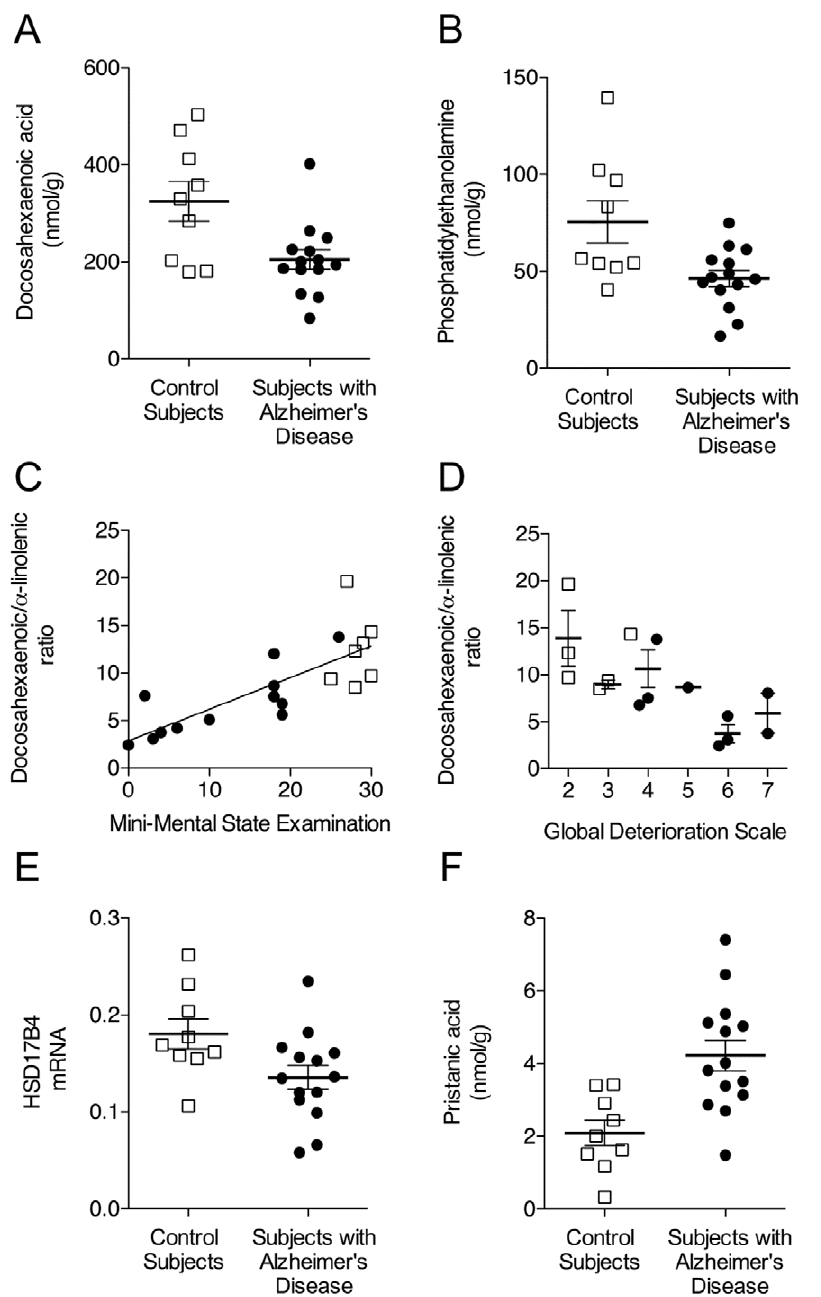
Figure 2. Liver metabolism in Alzheimer’s disease patients. Levels of free docosahexaenoic acid (Panel A) and 1-O-1 9 -( Z )-octadecenyl, 2- docosahexaenoyl- sn -glycero-3-phosphoethanolamine (Panel B) in liver tissue from control subjects (open squares) and Alzheimer’s disease patients (closed circles). Correlation between individual docosahexaenoic/ a -linolenic ratios in liver and most recent Mini-Mental State Examination scores (Panel C) or global deterioration scale grades (Panel D). HSD17B4 mRNA, encoding for D -bifunctional protein (Panel E) and pristanic acid levels (Panel F) in liver from control subjects (open squares) and subjects with Alzheimer’s disease (closed circles). Lipid content is expressed in nanomoles per gram of wet tissue and mRNA levels are expressed in arbitrary units. There were statistically detectable differences between control subjects and Alzheimer’s disease patients in the levels of docosahexaenoic acid (P=0.0077) and 1-O-1 9 -( Z )-octadecenyl, 2-docosahexaenoyl- sn -glycero-3- phosphoethanolamine (P=0.003) by two-tailed Welch’s t -test. There was a significant correlation between docosahexaenoic/ a -linolenic ratios in liver and Mini-Mental State Examination scores with use of the partial correlation analysis after adjustment for age, gender and post mortem interval. Global deterioration scale grades correlate significantly (P=0.013) with the docosahexaenoic/ a -linolenic ratios using a linear regression analysis adjusting for age, gender and post mortem interval. There were statistically detectable differences between control subjects and patients in the levels of HSD17B4 mRNA (P=0.048) and pristanic acid (P=0.0009) by two-tailed Welch’s t -test.